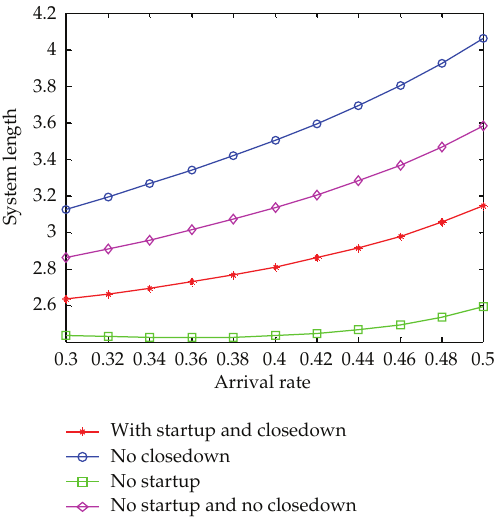
Figure 6: Plot of mean length in the system versus arrival rate with N ∼ Geo (cid:3) 0 . 3 (cid:4) , S ∼ Geo (cid:3) 0 . 4 (cid:4) , C ∼ Geo (cid:3) 0 . 5 (cid:4) , and B ∼ Geo (cid:3) 0 . 7 (cid:4) , the values of arrival rate λ varying from 0.3 to 0.5 by the increment